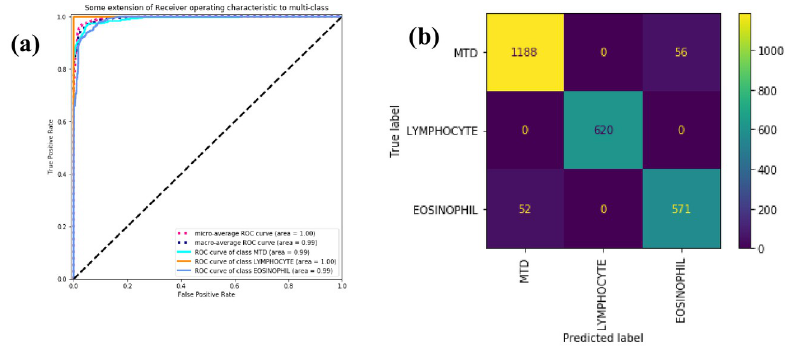
Fig 4. ROC curve and confusion matrix. (a) ROC curve of three subtypes of WBC. (b) Confusion matrix of three subtypes of